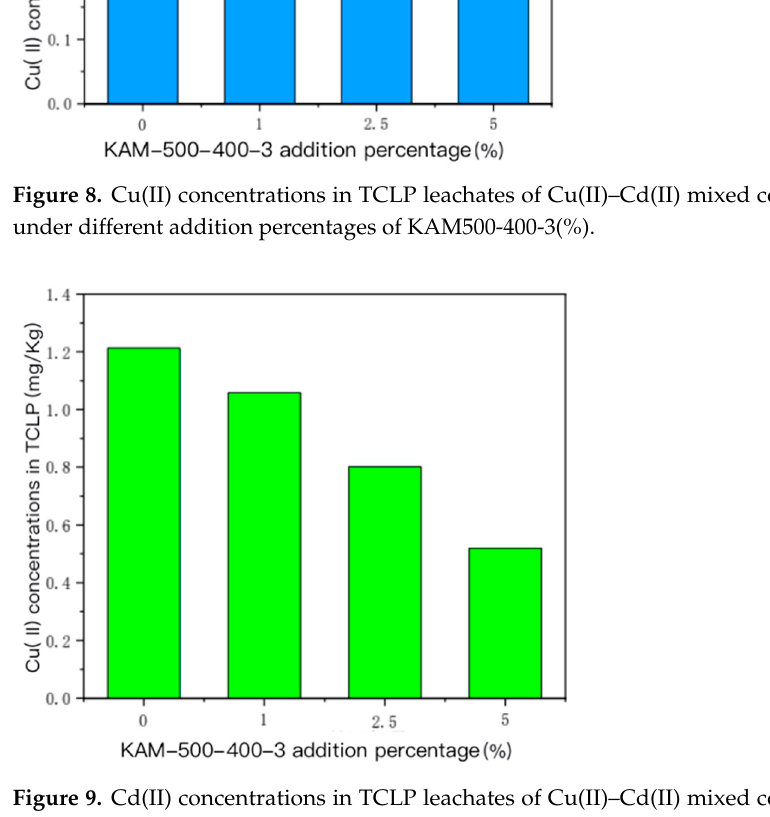
Figure 9. Cd(II) concentrations in TCLP leachates of Cu(II)–Cd(II) mixed contaminated sediment under different addition percentages of KAM500-400-3.